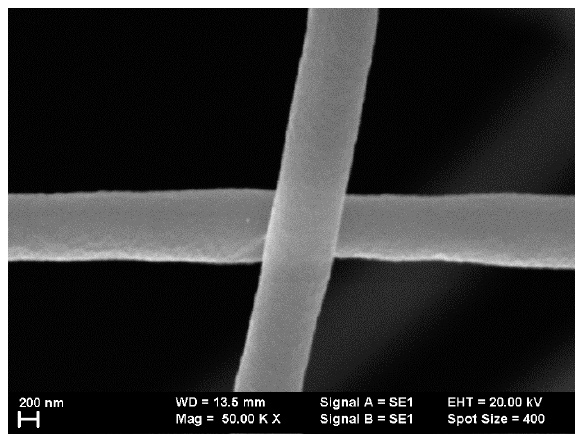
Figure 4. Scanning electron microscopy (SEM) image presenting the surface uniformity for rhodamine 6G (Rh 6G)-doped polymer fibers.